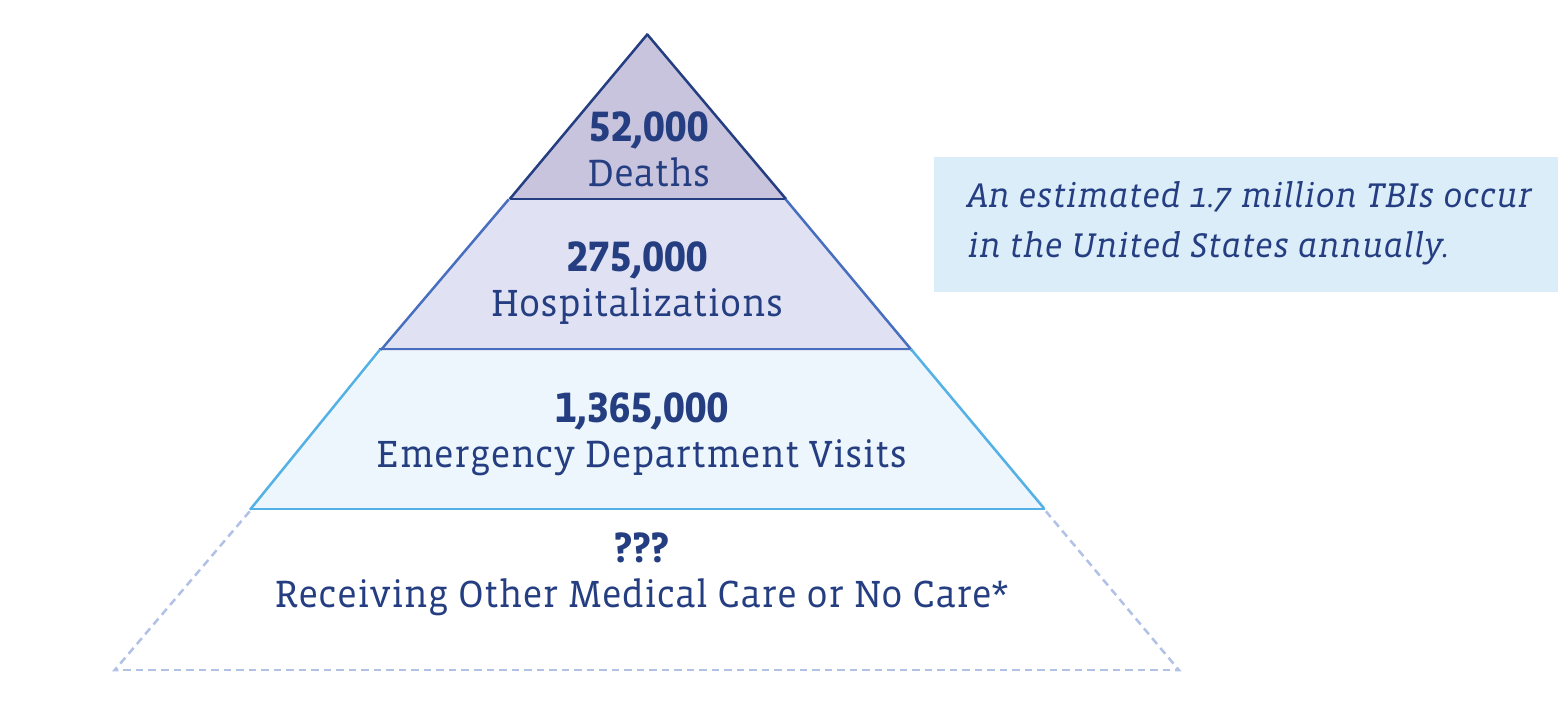
FIGURE 1: Estimated Average Annual Number of Traumatic Brain Injury-Related Emergency Department Visits, Hospitalizations, and Deaths, United States,